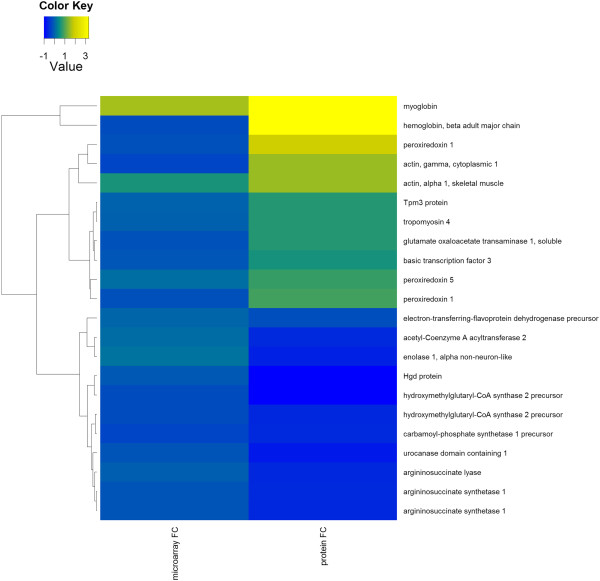
Comparison of gene and protein data using unsupervised hierarchical clustering in the liver. Comparison of gene (“microarray FC”) and corresponding protein (protein FC) expression levels in liver tissue of mice receiving adequate levels of folate and selenium post-weaning with expression levels in liver of mice with low dietary selenium and folate. Yellow (fold change >1) indicates greater expression in HF-Low-Suf mice, blue (fold change < 1) indicates greater expression in HF-Low-Low mice. Proteins and genes were non-hierarchically clustered according to similarity in fold change. Multiple instances of genes/protein names indicate multiple microarray probes/protein spots. Data for all gene expression changes are shown in Additional file 1: Table S1 and Additional file 2: Table S2, and for protein changes in Figure 1.